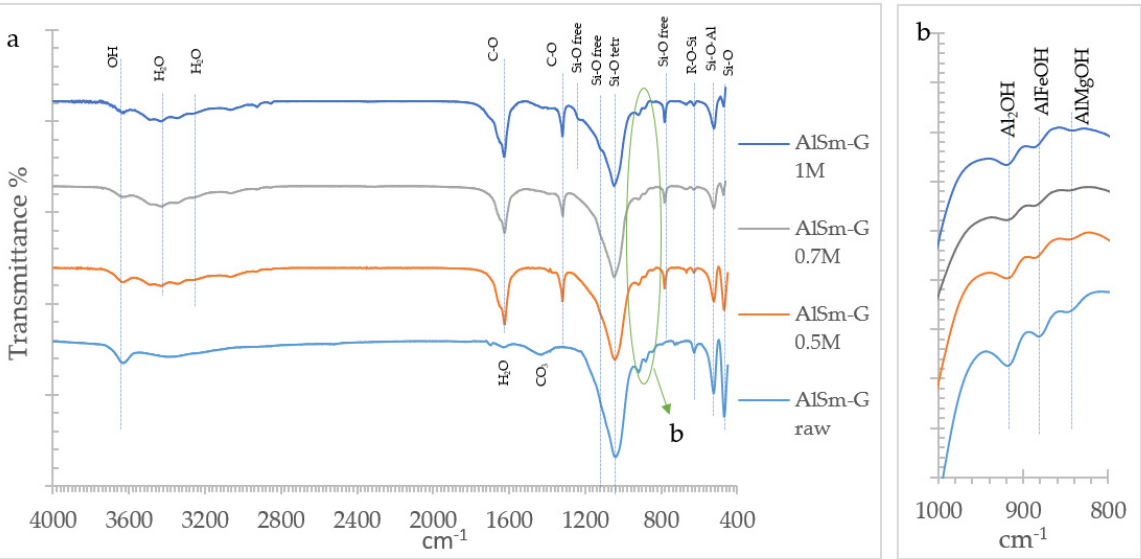
Mater. Proc. 2021 , 5 , 113 5 of 8